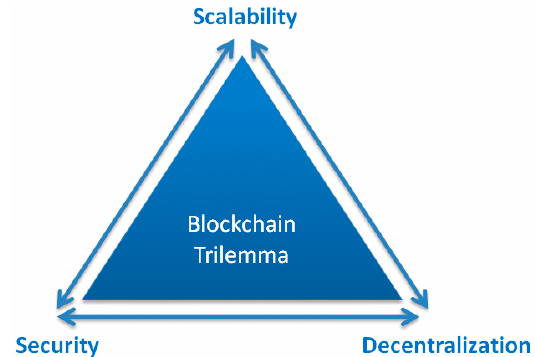
Figure 1. Scalability trilemma.